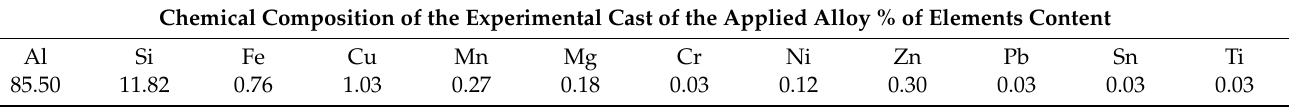
Table 7. Chemical composition of experimental meltage of used alloy % content of elements. Chemical Composition of the Experimental Cast of the Applied Alloy % of Elements Content